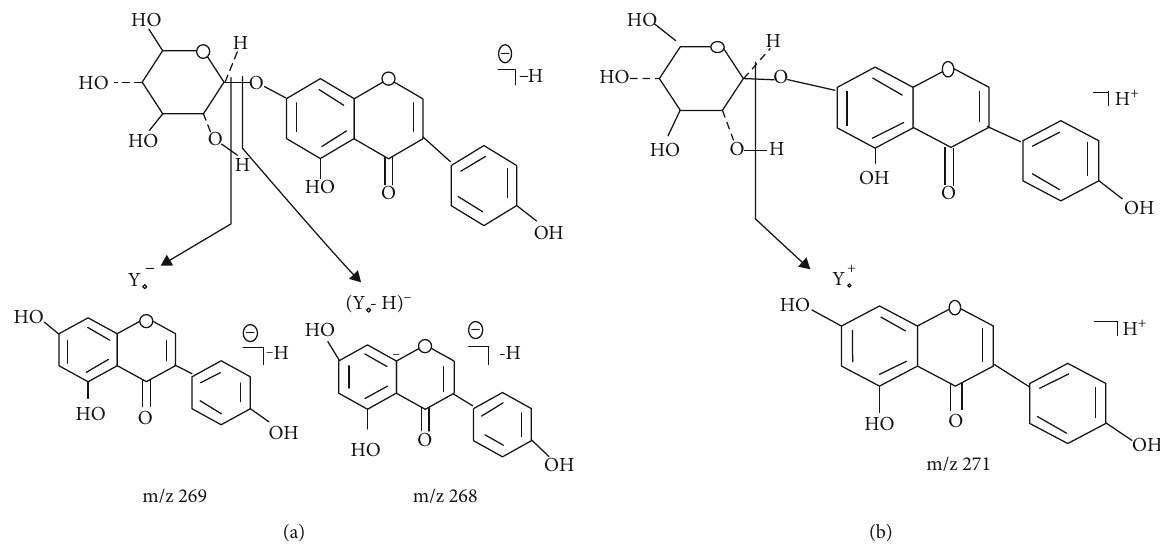
Figure 3: Fragmentation pattern of parent ion of genistein obtained by negative ion mode of UPLC-APCI-TOF-MS. (a) Fragmentation pattern of deprotonated glycoside to form free genistein. (b) Fragmentation pattern of protonated glycoside to form free genistein.